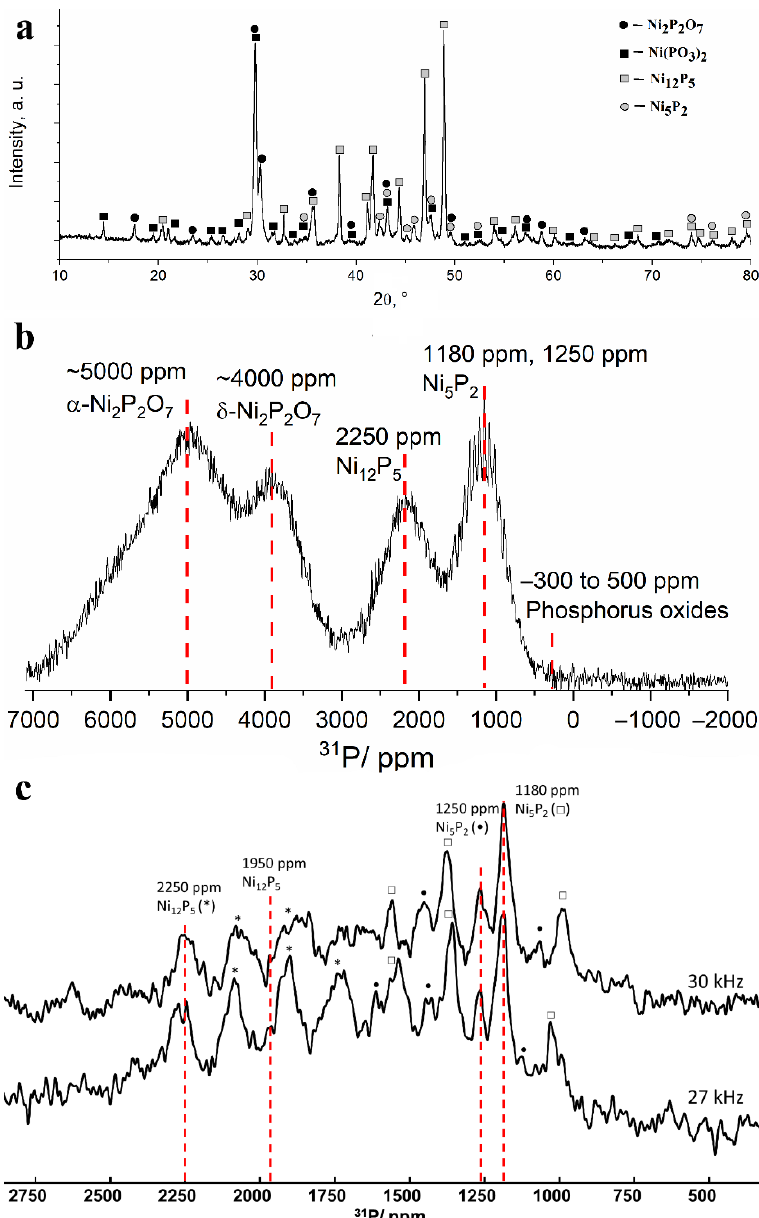
Figure 7. ( a ) X-ray diffraction pattern and ( b ) 13 kHz MAS 31 P NMR spectrum obtained for the separated fine powder after heating at 800 °C in vacuum. ( c ) Comparison of 30 kHz (top) and 27 kHz (bottom) MAS 31 P NMR spectra. Asterisk, circle and square denote the corresponding spinning sidebands of Ni 12 P 5 (2250 ppm line), Ni 5 P 2 (1250 ppm line) and Ni 5 P 2 (1180 ppm line), respectively.